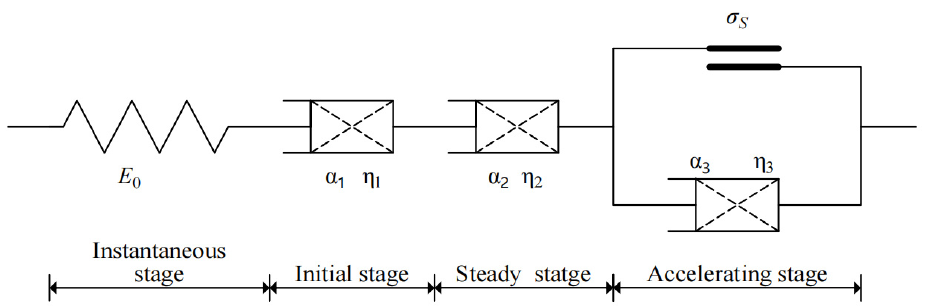
Figure 9. Variable-order fractional creep constitutive model.